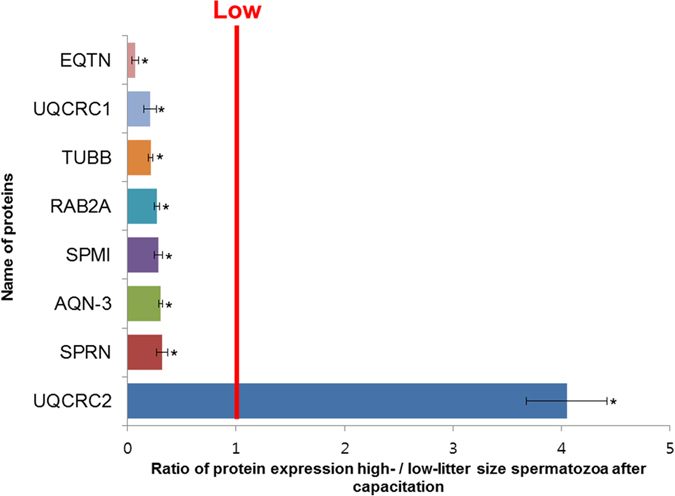
Comparison of proteins from high- and low-litter size spermatozoa after capacitation.Differentially expressed (>3-fold) proteins were identified by comparing high- and low-litter size spermatozoa (*P < 0.05). The line indicates equal expression in high- and low-litter size spermatozoa. The data represent the mean ± SEM, n = 3.